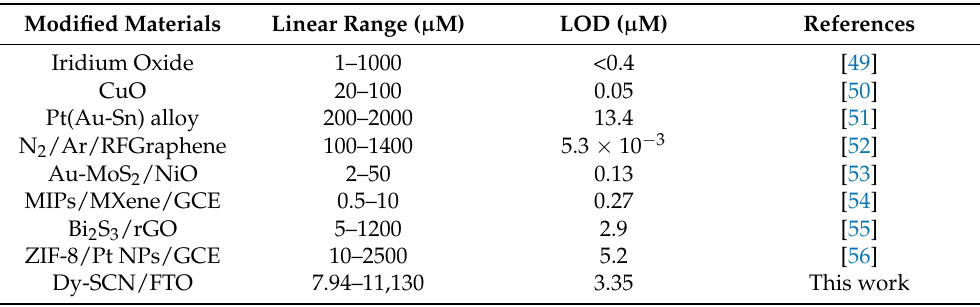
Table 1. Comparison of linear range and detection limit of enzyme-free electrochemical methods for determination of AA.